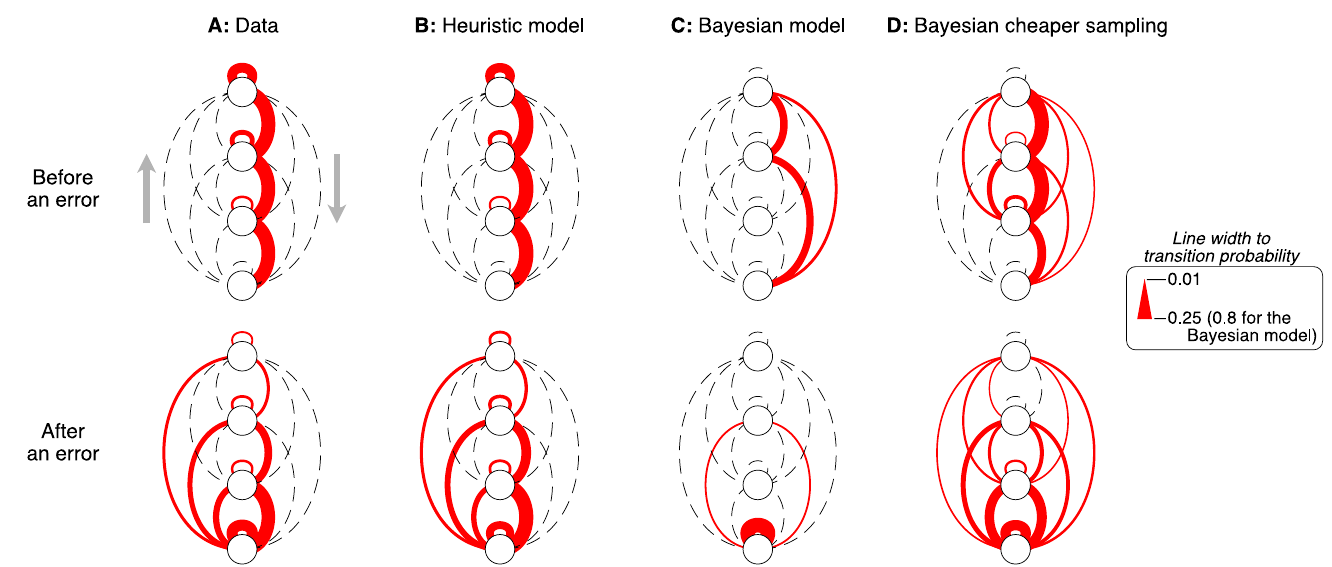
Fig 8. Participants and heuristic model made similar transitions between levels. Transition frequencies between levels of the decision tree, obtained by grouping all nodes from the same level. The top row shows the transitions before making an error at a leaf node. The bottom row shows the transition after at least one error at a leaf node. The width of the red lines is proportional to the transition frequency. The dashed lines are placeholders for infrequent transitions. The last column corresponds to a Bayesian model in which the cost of querying internal nodes was reduced to 30% of its true value. In each of the 8 panels, transitions to a lower level are shown on the right, and transitions to a higher level are shown on the left. The ribbon identifies transitions between nodes at the same level of the decision tree (including re-queries). Transition probabilities were first calculated per participant, and then averaged across participant (see Methods).